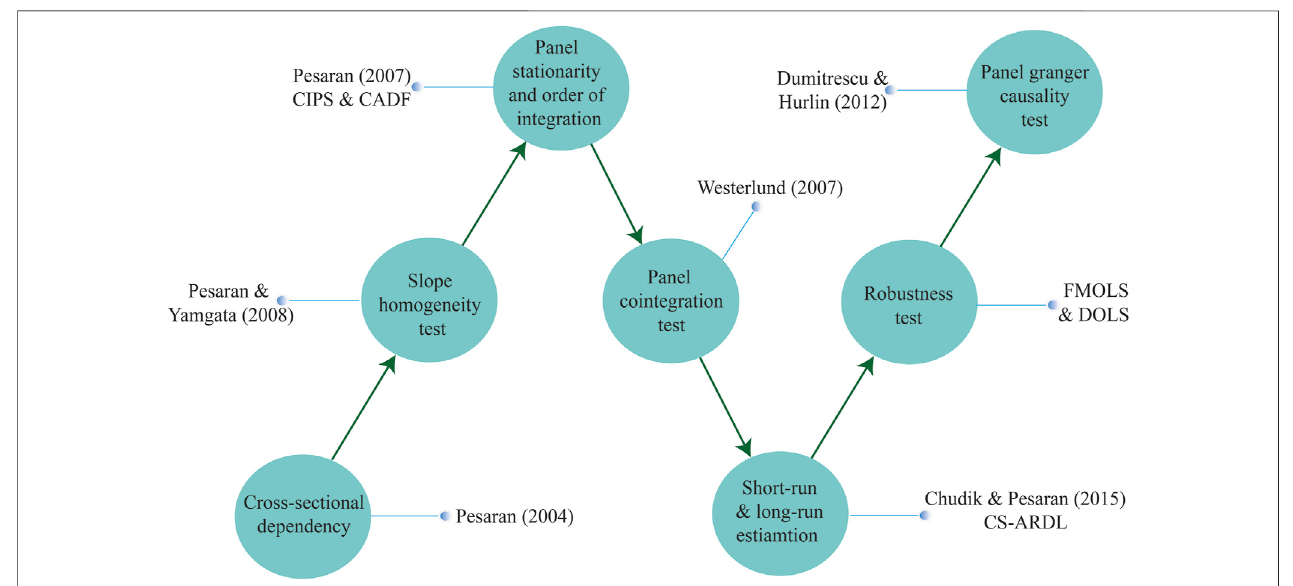
FIGURE 1 | Panel empirical estimation